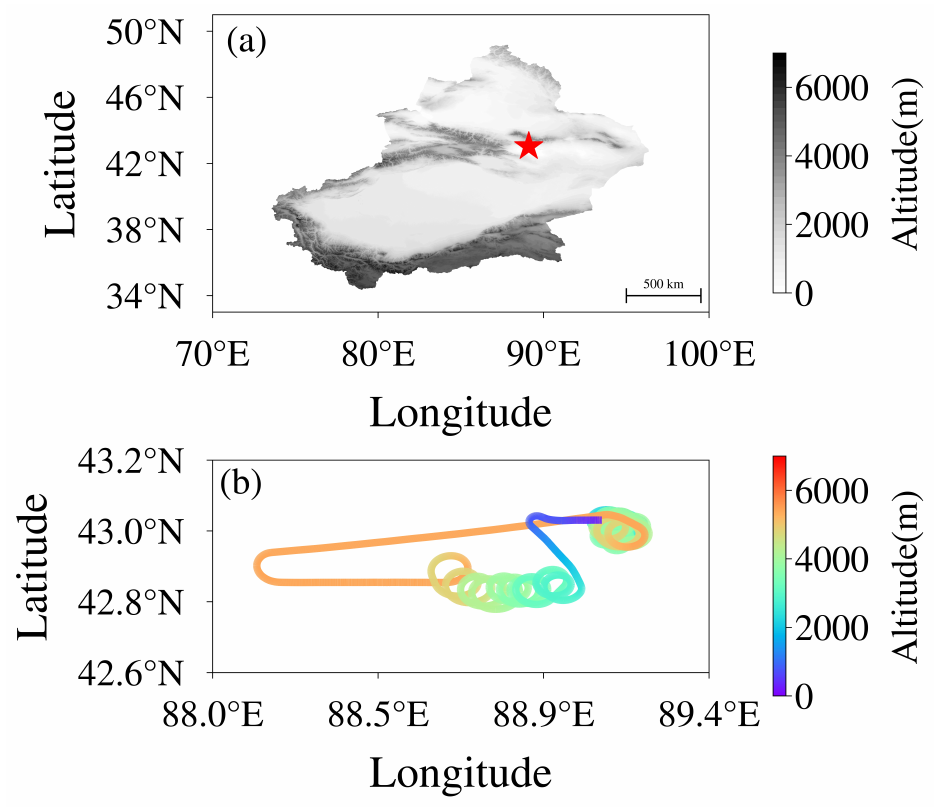
Figure 1. ( a ) The map of the observation site. ( b ) The flight trajectory of Kingair aircraft. The red stars represent the location of Turpan. (“Altitude” in this study all represent the altitude above mean sea